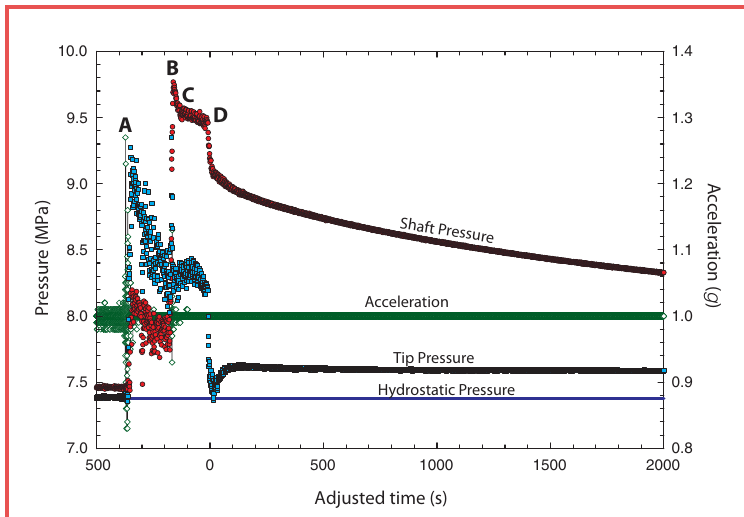
Figure 4. MDHDS deployment record. Zero time is set to the onset of pressure dissipation. At Pt. A (-400 s), the MDHDS latch is released, and the IBS and the attached T2P descend by gravity driving the tip a small distance into the formation. As a result, the tip pressure (blue) and the shaft pressure (red) rise abruptly. The accelerometer (green) records rapid changes in acceleration. At Pt. B, the drillstring is re-pressurized, and the penetrometer is driven into the formation (e.g., Fig. 3c). At Pt. C, we interpret that the penetrometer has been driven the maximum 2.9 m of stroke that is possible (Fig. 3c). Between Pt. C and Pt. D, there is ongoing circulation but no longer any significant driving force. At Pt. D, the circulation pumps are turned off, and pressure dissipation